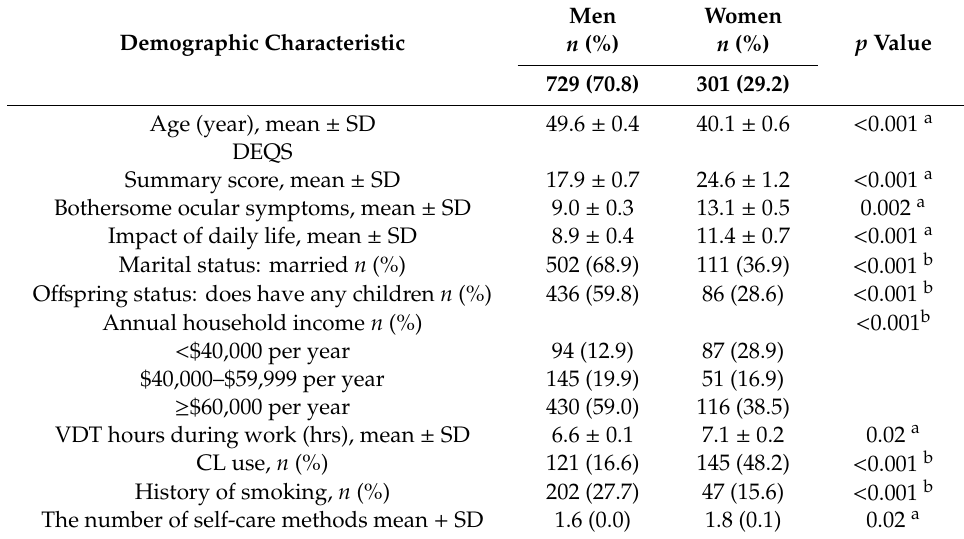
Table 1. The distribution of the study